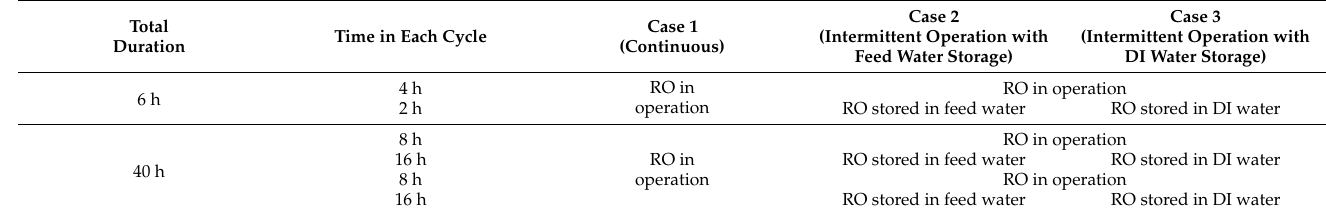
Table 1. Summary of operating conditions for RO